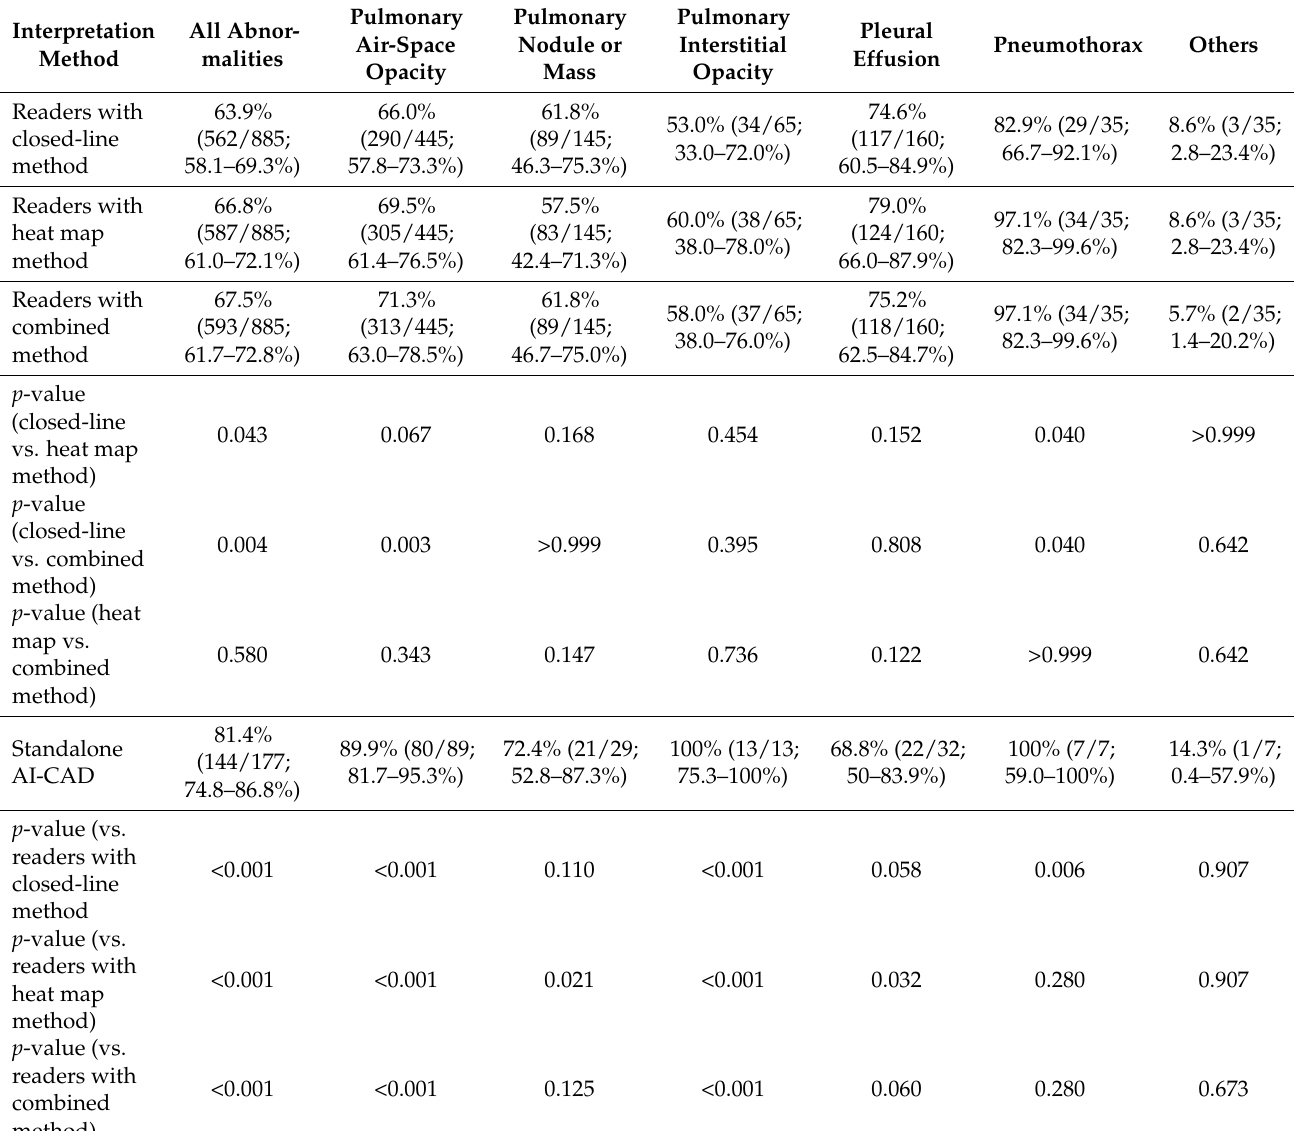
Table 4. Detection rates of readers and stand-alone AI-CAD for different types of abnormalities.